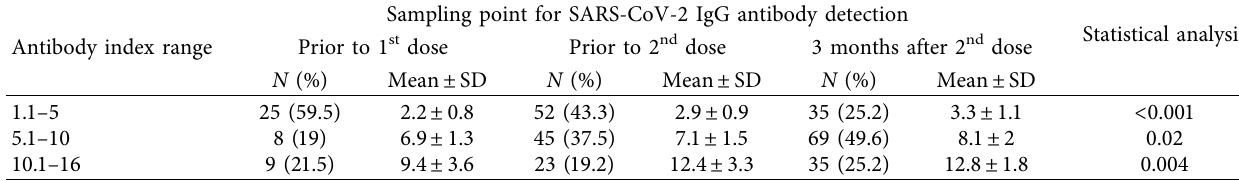
Statistical analysis